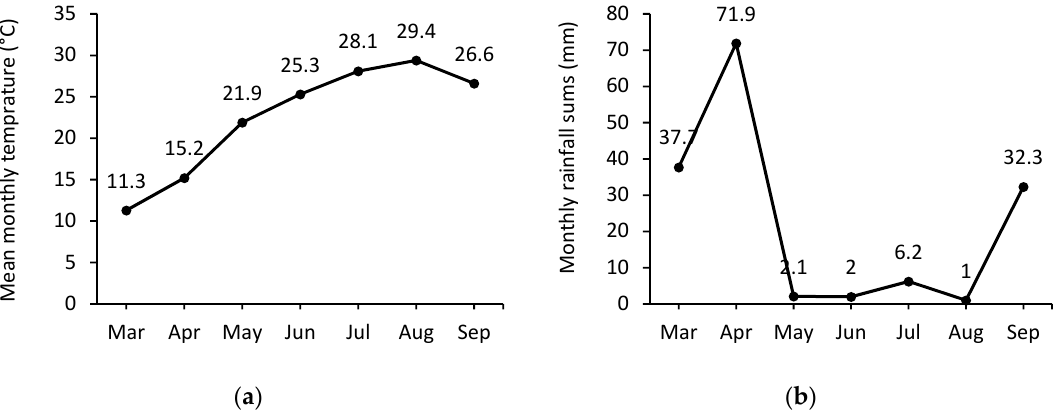
Figure 1. Climatic conditions during the experimental period: ( a ) mean monthly temperatures; ( b ) monthly rainfall sums.